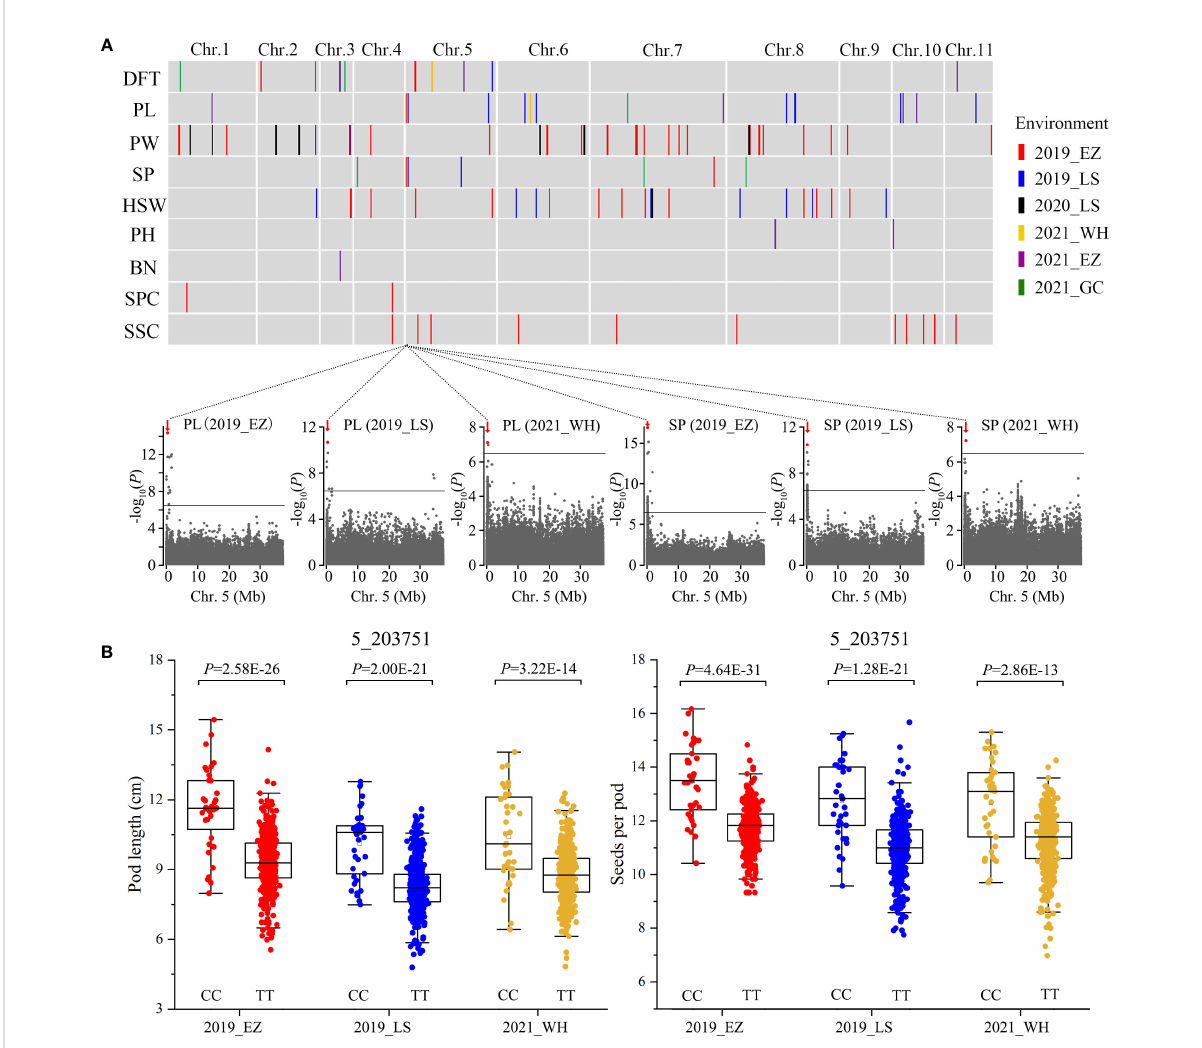
FIGURE 2 GWAS for nine agronomic traits and identi fi cation of the SP5 locus on chromosome 5. (A) The distribution of the associated loci for nine agronomic traits in mungbean. Differently colored vertical lines indicate the associated loci for each trait: days to fl owering time (DFT), pod length (PL), pod width (PW), seeds per pod (SP), 100-seed weight (HSW), plant height (PH), branch number (BN), seed protein content (SPC), and seed starch content (SSC). In the plots below, horizontal solid lines indicate the signi fi cance threshold ( P < 3.87E-07, – log 10 P = 6.41). Red arrows indicate strongly associated loci for both PL and SP at 0.16-0.28 Mb on chromosome 5, designated as SEEDS PER POD ON CHROMOSOME 5 ( SP5 ). The red dot indicates the peak SNP (5_203751, CC/TT). (B) Box plots illustrating PL and SP for the CC and TT alleles. Statistical signi fi cance for each environment was determined by a two-tailed t